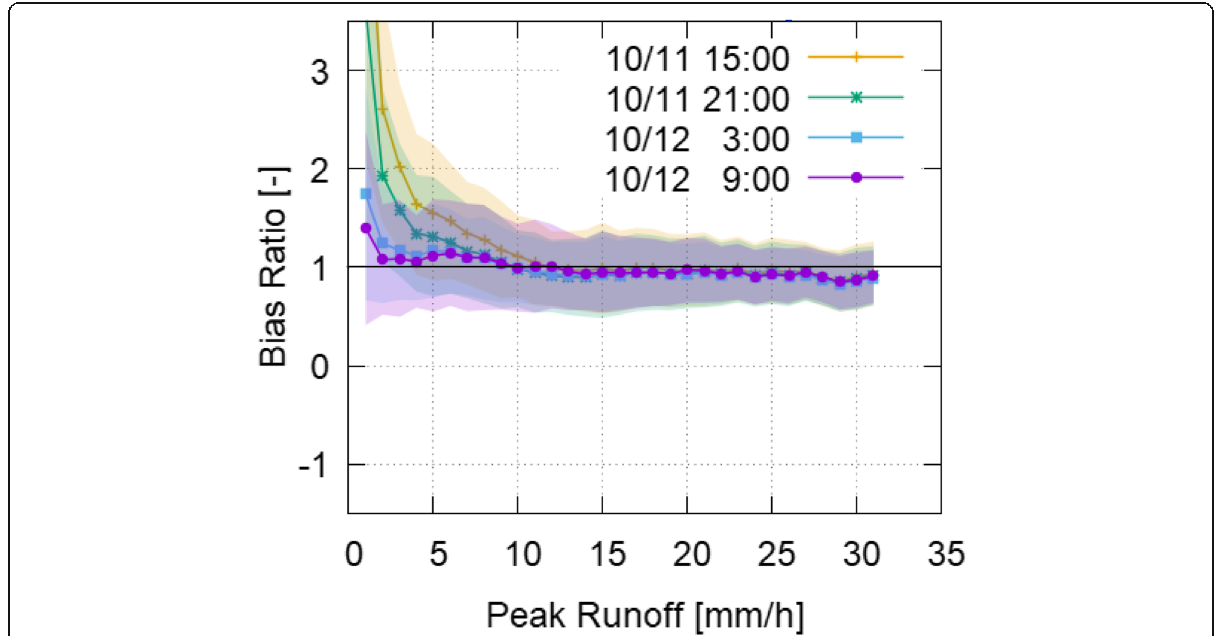
Fig. 12 The effects of different initial times on the forecasted hydrograph evaluated by the bias ratio (BI) in Kanto Region for T19